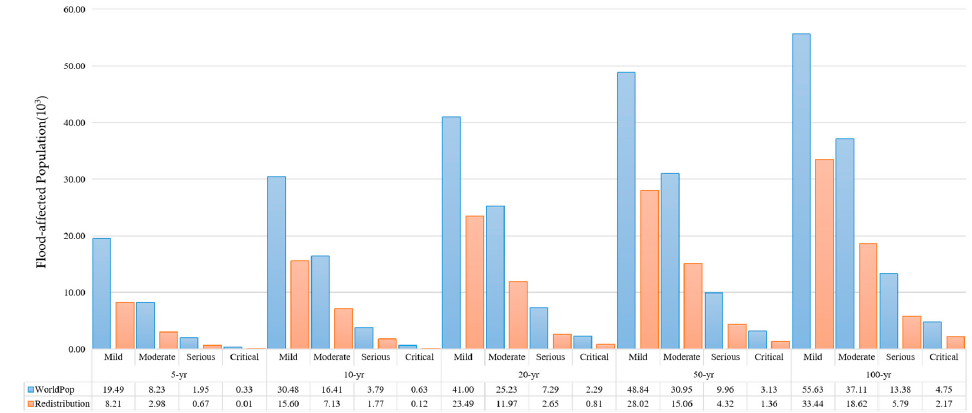
Figure 9. Comparison of the extent of urban flooding under different rainfall return periods.